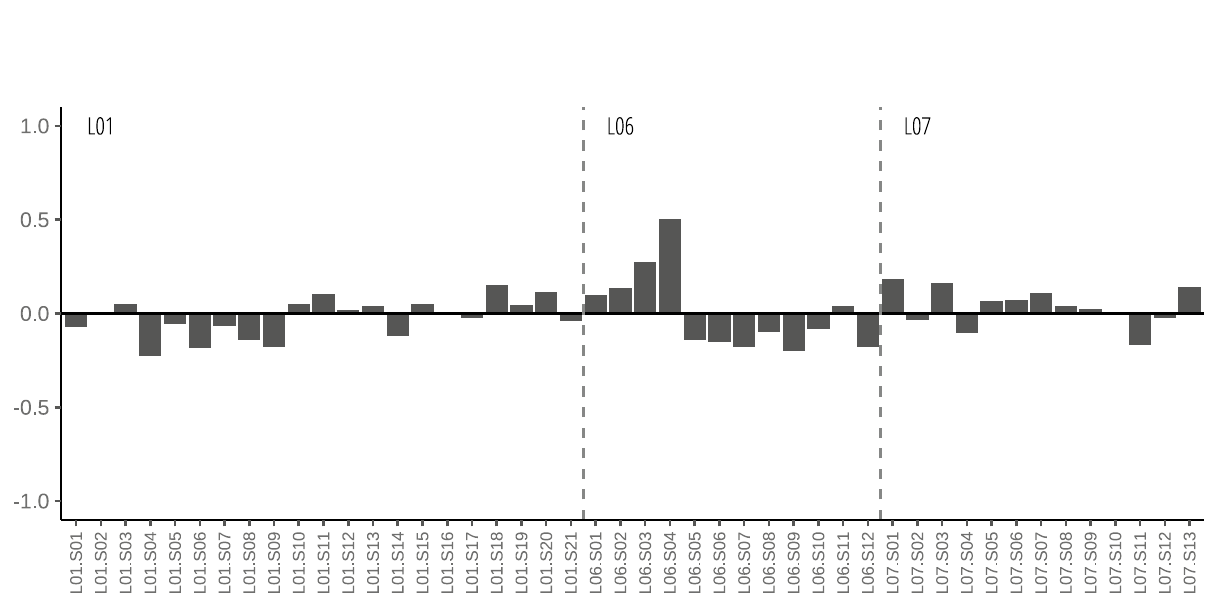
Figure 3. PLSR model